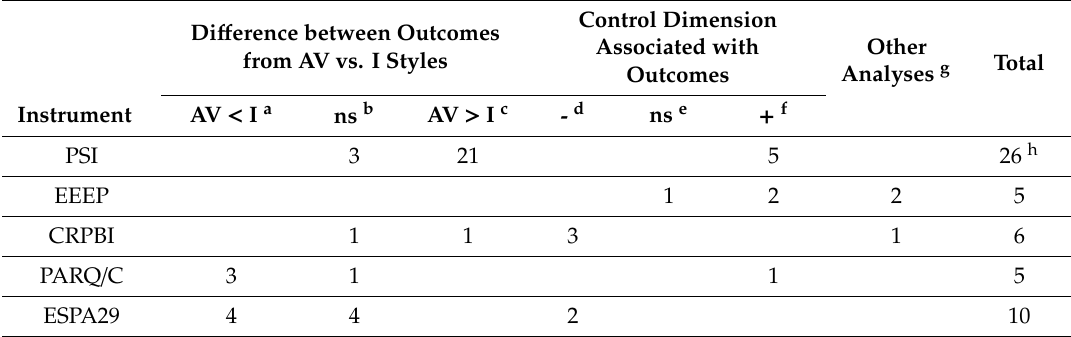
Table 5. Results, depending on the instrument